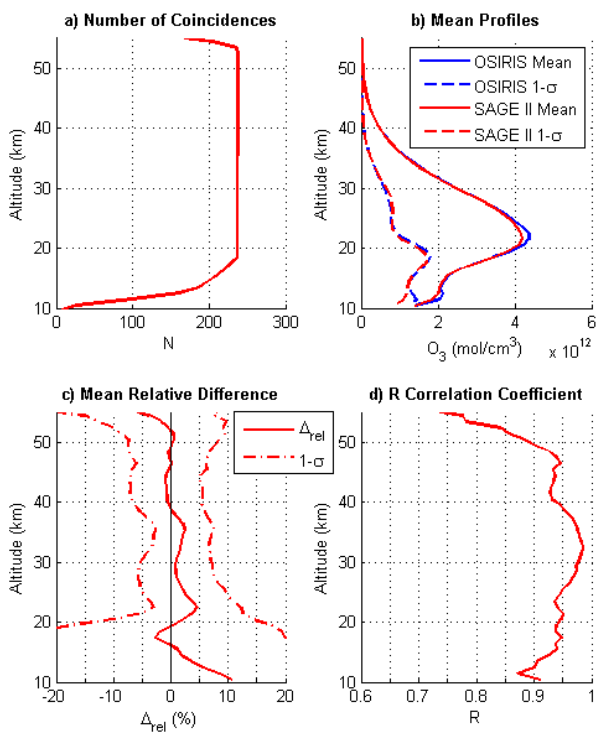
Fig. 3. Comparison results for narrow coincidence criteria (see Ta- ble 1). (a) Number of coincidences. (b) Mean number density pro- Figure 3: Comparison results for narrow coincidence criteria (see Table 1). (a) Number of 2 files (solid lines) and standard deviation (dashed lines) for OSIRIS coincidences. (b) Mean number density profiles (solid lines) and standard deviation (dashed 3 (blue) and SAGE II (red). (c) Mean relative difference for OSIRIS lines) for OSIRIS (blue) and SAGE II (red). (c) Mean relative difference for OSIRIS minus 4 minus SAGE II (red solid line) with standard deviation (red dashed SAGE II (red solid line) with standard deviation (red dashed lines). lines). (d) R correlation coefficient for OSIRIS vs. SAGE